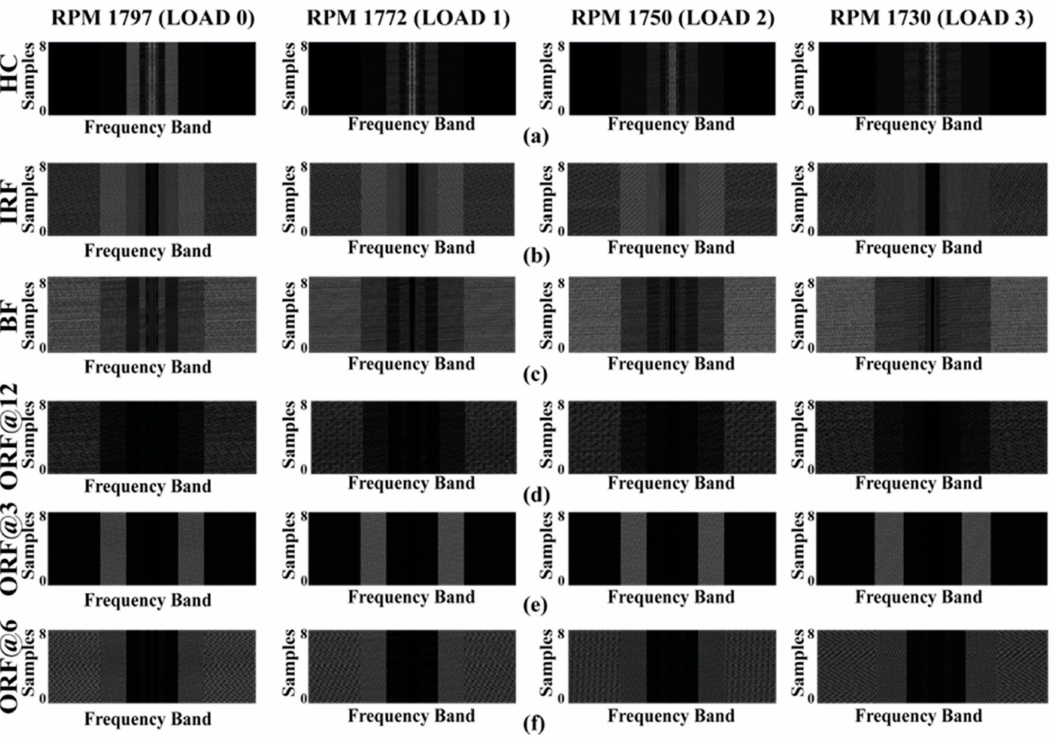
Figure 7. Vibration images based on DOST for different health conditions. ( a ) HC (Healthy Condition), ( b ) IRF (Inner Race Fault), ( c ) BF (Ball Fault), ( d ) ORF (Outer Race Fault), and ( f ) ORF at opposite